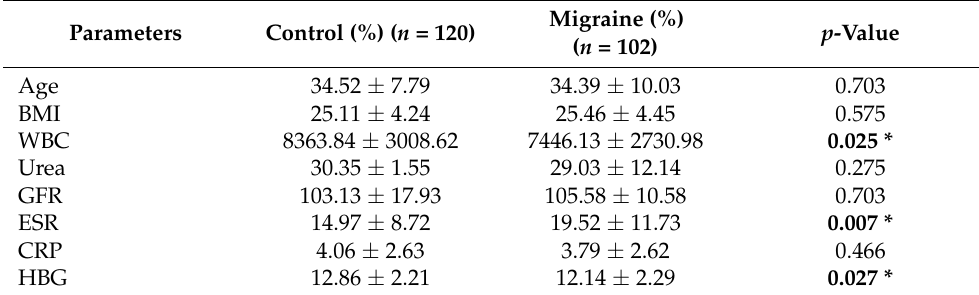
Table 2. Blood parameters between the groups.